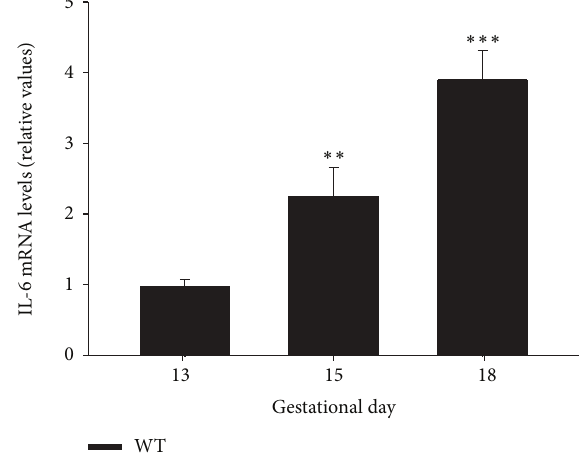
Figure 2: IL-6 mRNA expression in placenta of WT (C57BL6) mice. 12-week-old WT mice were time-pregnant and placental IL- 6 mRNA levels at different pregnancy stages (13, 15, and 18 days) were assessed by real-time qPCR; 𝑛 = 5 - 6 . Relative mRNA levels were normalized to 13 days pregnant mice values as 1. Each value represents the mean ± SEM. One-way ANOVA: ∗∗ 𝑃 < 0.01 versus 13 days pregnant mice